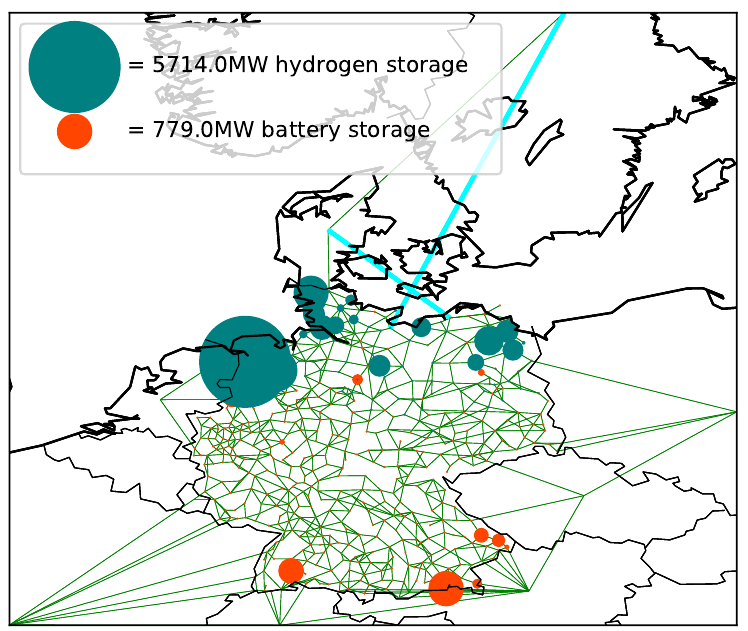
Figure 7. Spatial distribution of additional storage units for a RES generation share of 67%. The size of the dot represents the storage capacity in MW. Blue dots show hydrogen storage units, red dots indicate battery storage units. Note: The dot size has been scaled down in contrast to Figure 2 for better